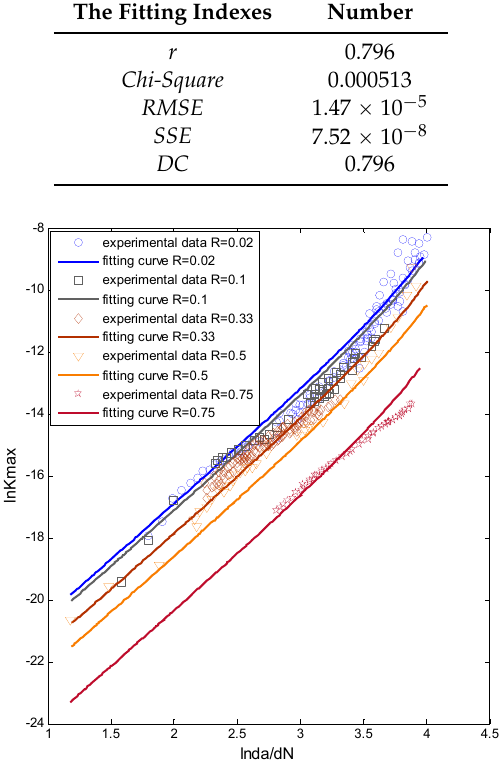
Figure 9. The fitting by Forman’s model vs. the testing data for Al7075-T6.